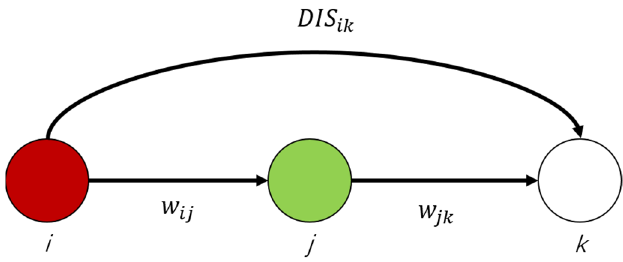
Figure 6. Weight calculation.